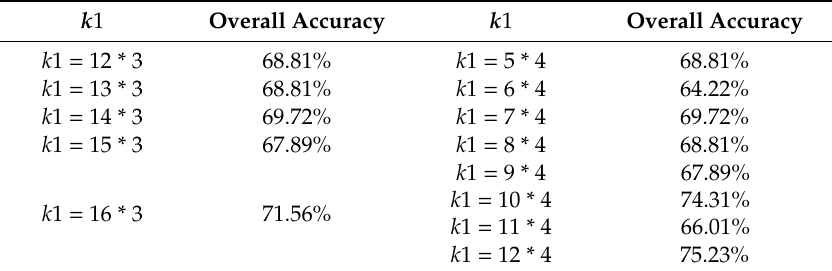
Table 6. The overall accuracy for the k 1 values in 2016, where k 1 refers to the division of the 2D data after dimension reduction into k1 bins. k 1 Overall Accuracy k 1